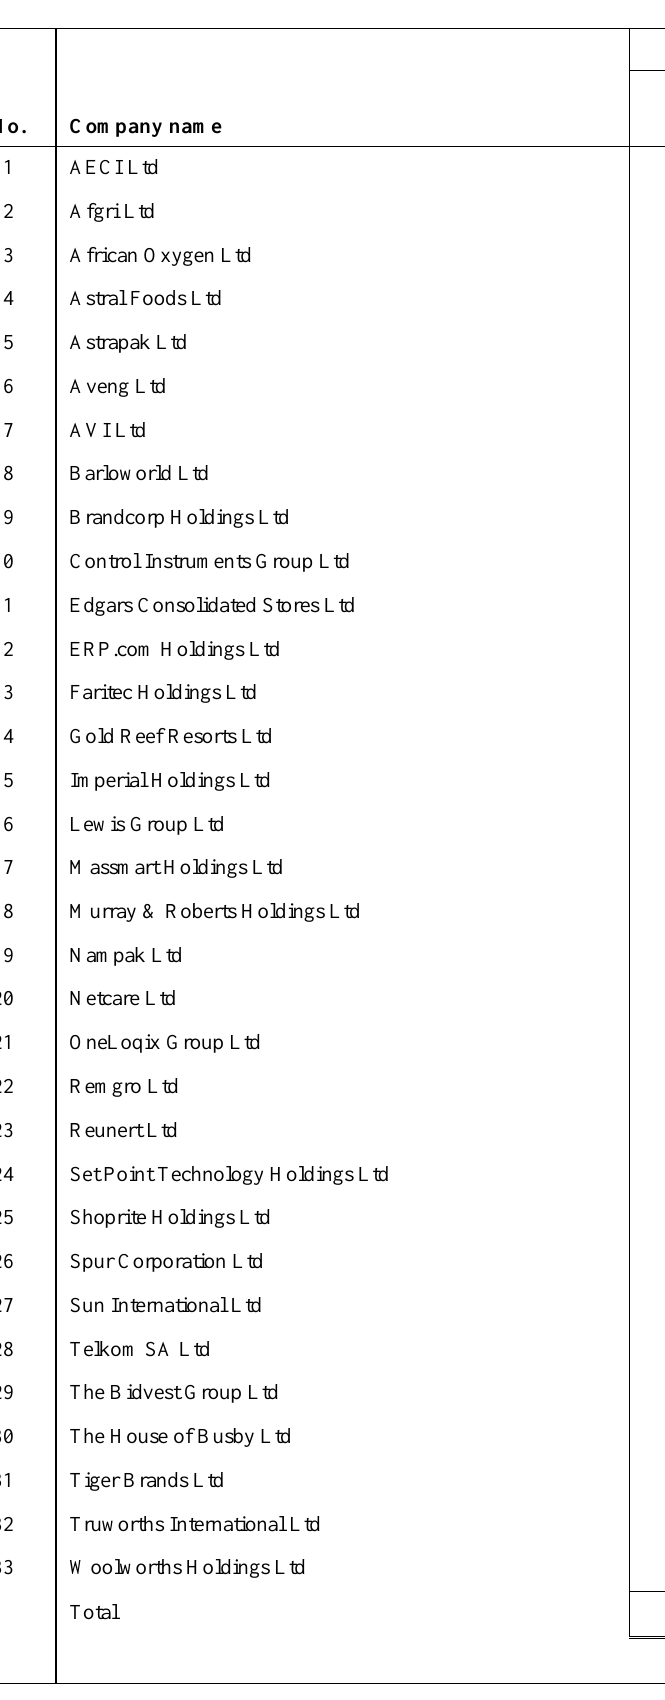
Table 1: Companies included in pilot